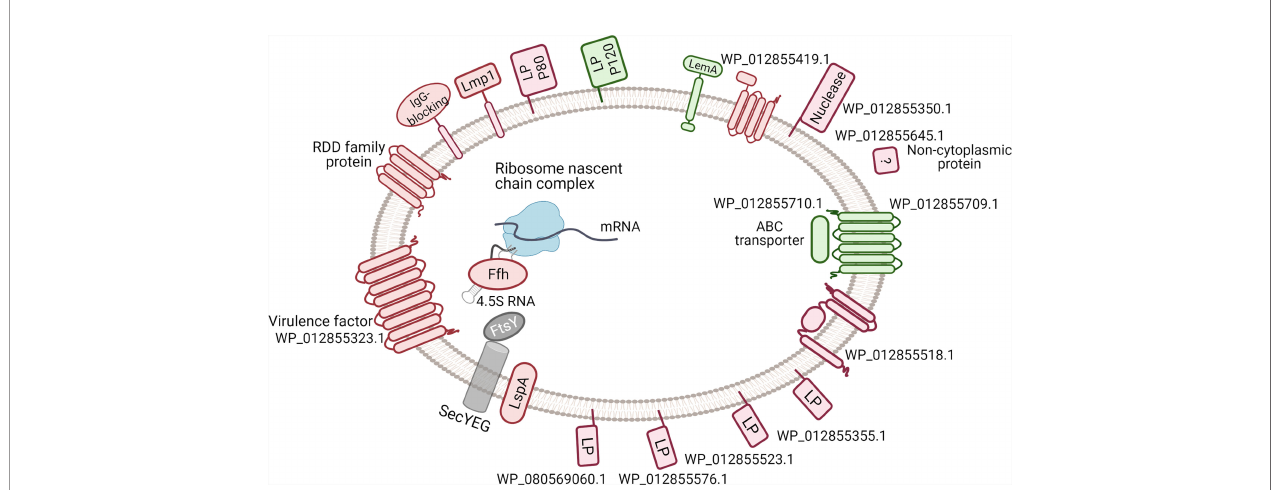
FIGURE 6 | Difference in the membrane-associated proteins under thymidine conditions comparing with arginine conditions. The down-regulated proteins are indicated red, up-regulated - in green, unchanged - in grey. The data about signal peptides, Lipo-box, transmembrane helices and functional domains was used in protein diagramming. The SRP-mediated protein targeting is shown. LP - lipoprotein. Only two signi fi cantly changed transmembrane proteins are not shown: PotC and PepF. The corresponding full names of proteins are given in Supplementary Tables S3 , S4